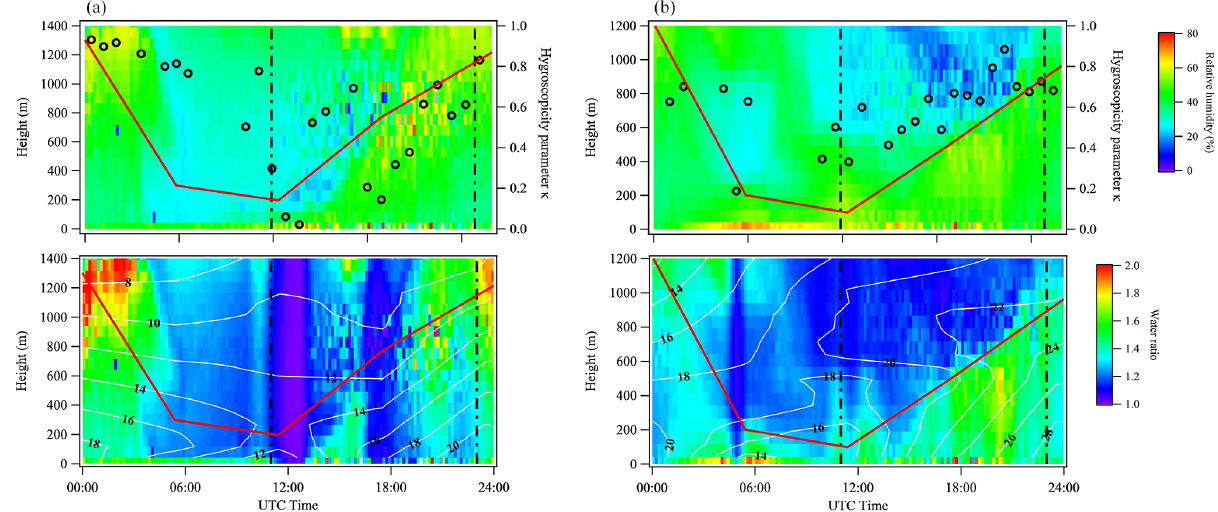
Figure 7. Vertically and temporally resolved relative humidity (upper plot) and estimated water volume ratio of 13nm particles (lower plot) at SGP on (a) 12 May 2013 and (b) 13 May 2013. The two vertical dashed lines in each plot represent 06:00 and 18:00 local time, respectively. The red line shows the boundary layer height determined from radiosonde data. Overlaid in the upper plot is the temporally resolved hygroscopicity parameter κ of 13nm particles obtained by TDMA (open black circles). Temperature ( ◦ C) is shown by the white contour lines in the lower